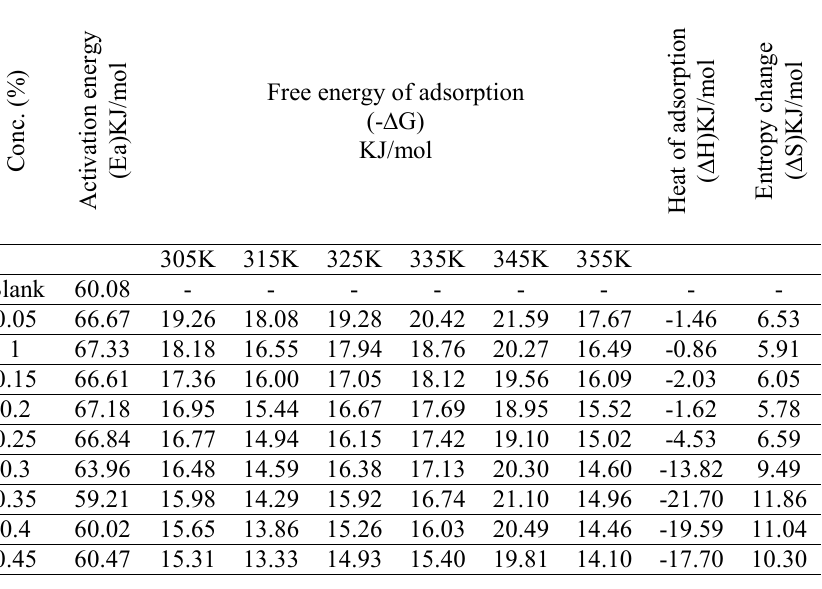
Figure 3. Langmuir adsorption isotherm for SFCN extract. Table 2. Kinetic and thermodynamic parameters during adsorption of inhibitor on MS surface in SFCN extract in 1M